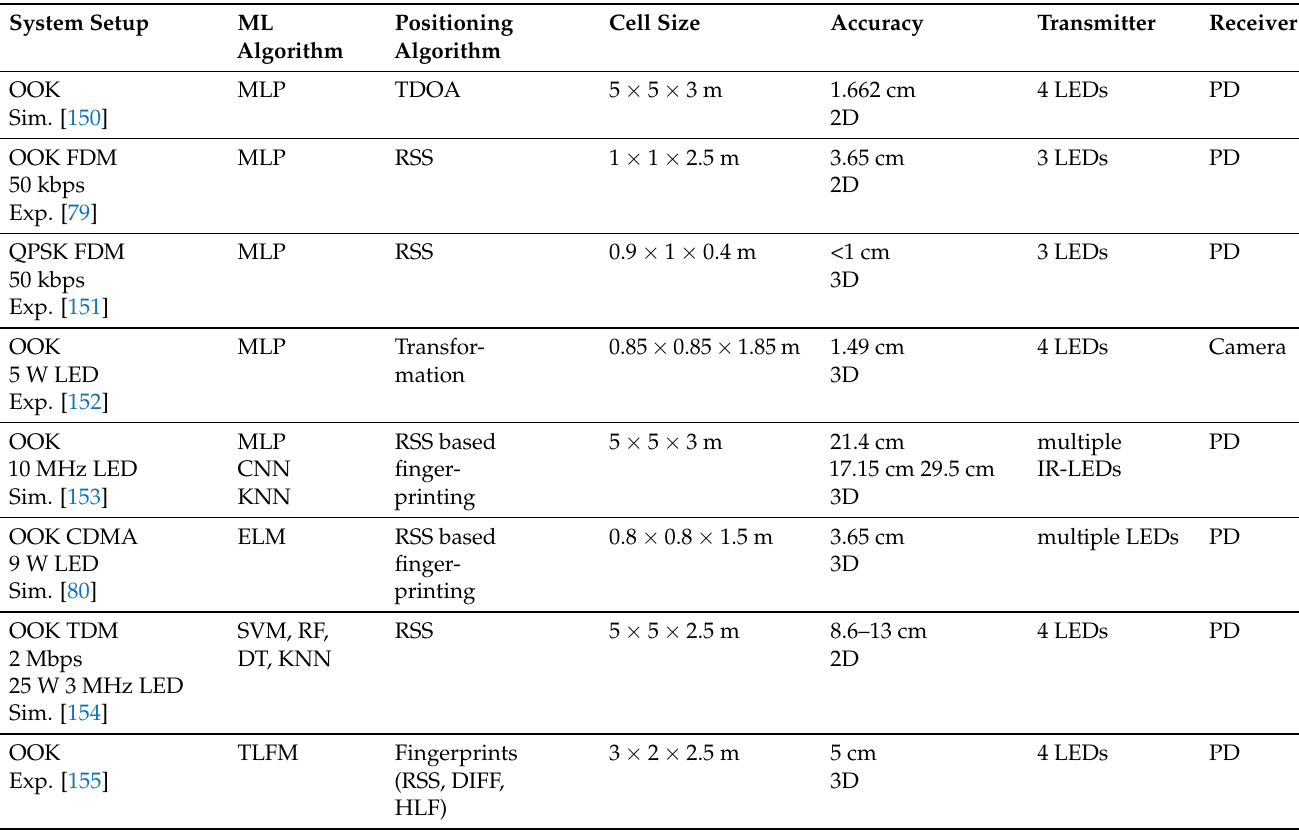
Table 4. A summary of current ML based indoor localization